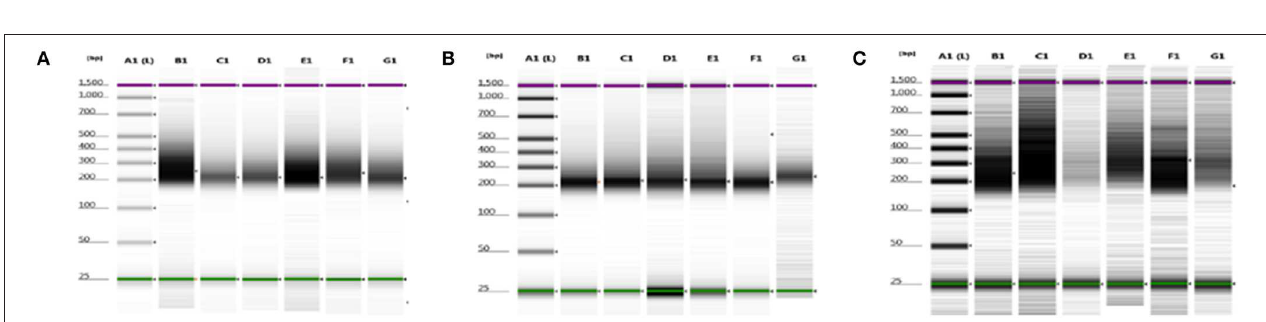
FIGURE 1 | Histological compartments: central tumor cells (tumor core astrocytes—TC), pseudopalisading cells surrounding the necrotic area (pseudopalisading astrocytes—PTC), infiltrating astrocytes forming perineuronal satellites (perineuronal astrocytes in satellitosis—PS), neurons surrounded by satellite astrocytes (neurons with satellitosis—NS), neo-vessels or microvascular proliferation (tumor blood vessels—TV) and normal blood vessels (NV).